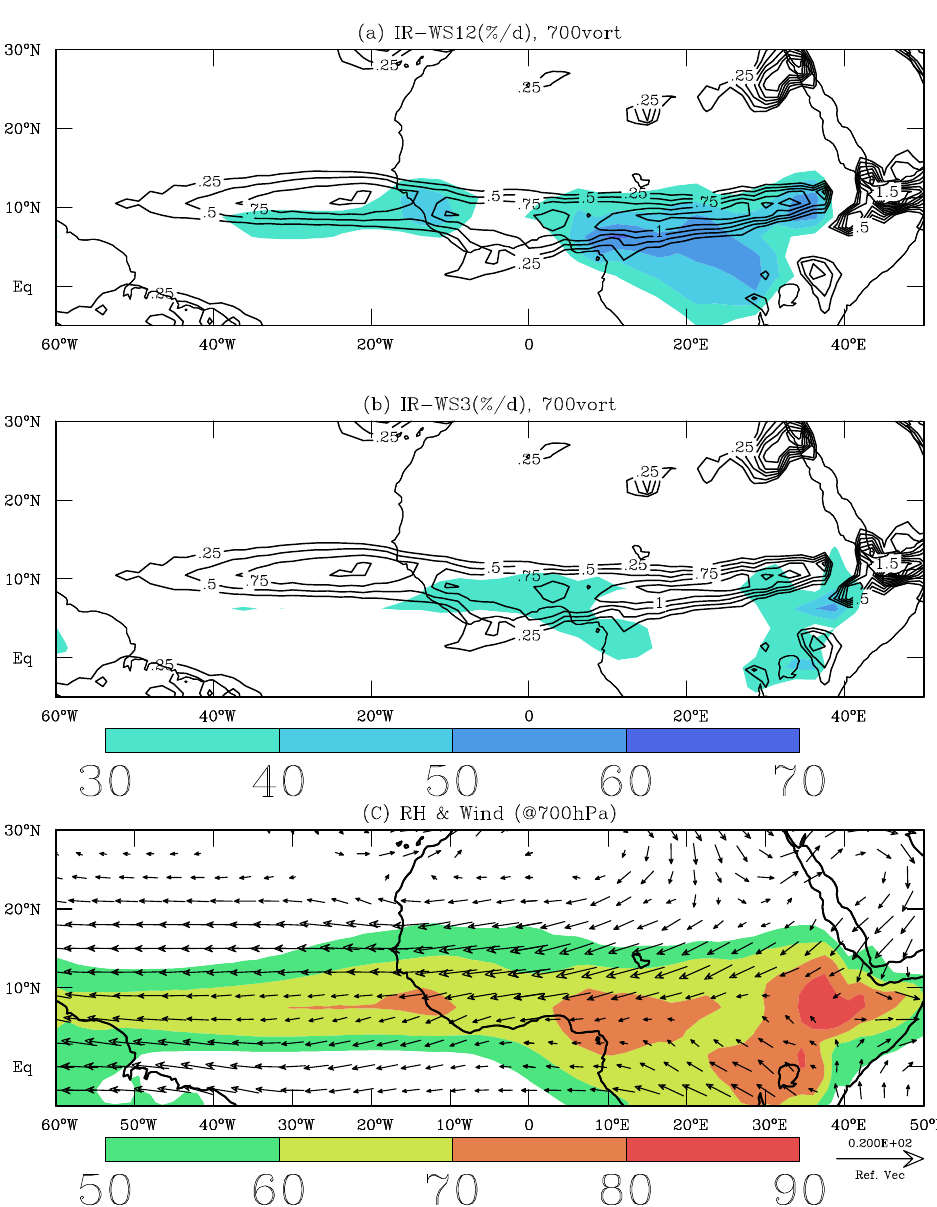
Figure 2. The July–October (JASO) 1984–2012 averages: ( a ) IR-WS12 (large scale well-organized deep convection) and 700 hPa relative vorticity; ( b ) IR-WS3 (scattered less well-organized deep convection) and 700 hPa relative vorticity; ( c ) 700 hPa relative humidity and horizontal wind. IR-WS12 and IR-WS3 are frequencies of occurrences per day (shaded as shown below the middle panel), and relative vorticity is contoured every 0.25 × 10 − 5 s − 1 . Mean relative humidity in panel ( c ) is shaded (%). Wind vectors are plotted every 3° and weaker winds (<10% of the maximum wind) are suppressed for clarity. The magnitude of the reference vector is 20 ms − 1 .